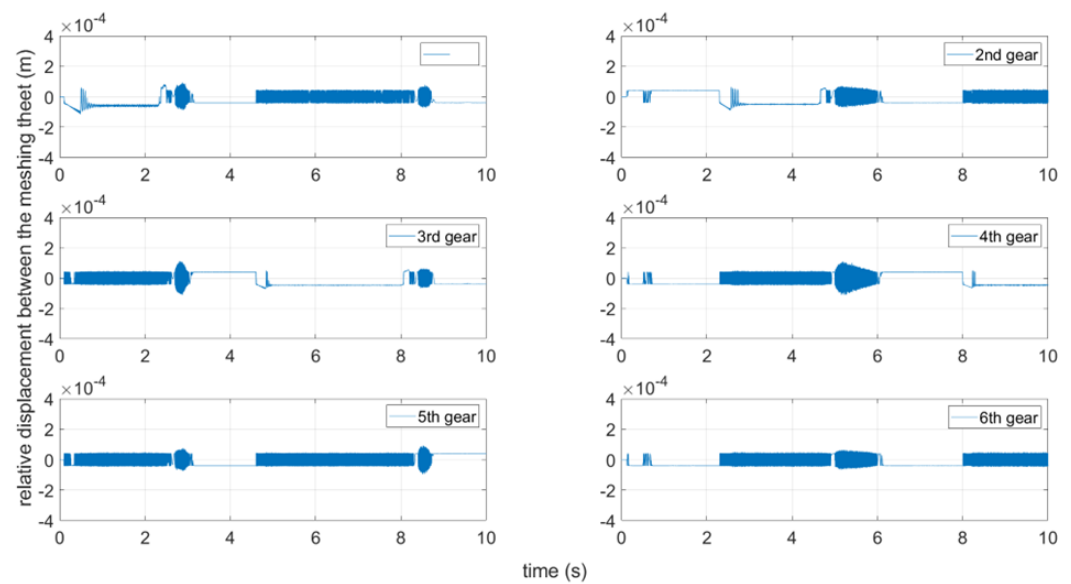
Figure 12. Angular relative motions of the various rattling gear pairs during a run-up transient: case